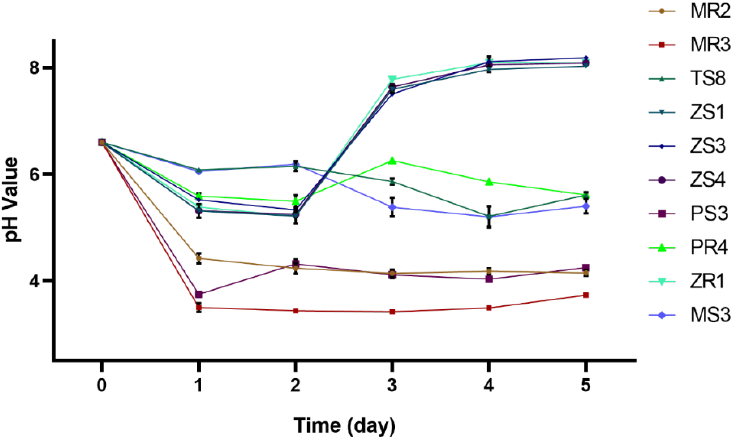
Figure 2. The variations of pH value after metabolizing glucose by screened bacterial isolates. The data were expressed as means ± standard deviation ( n = 3) and the statistical analysis was calcu- lated by ANOVA and Tukey’s